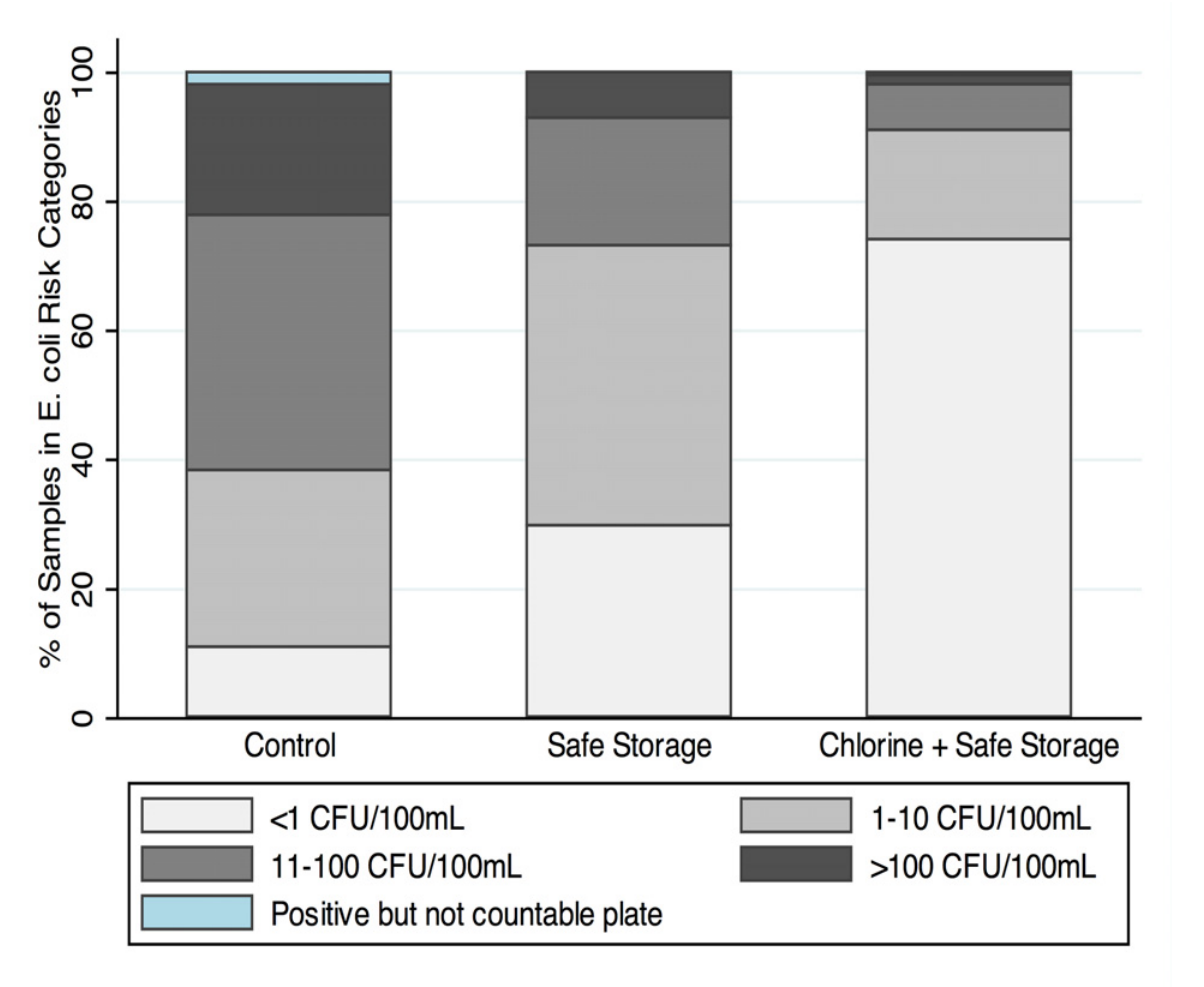
Fig 3. Categories of E . coli counts in stored water across arms (see S6